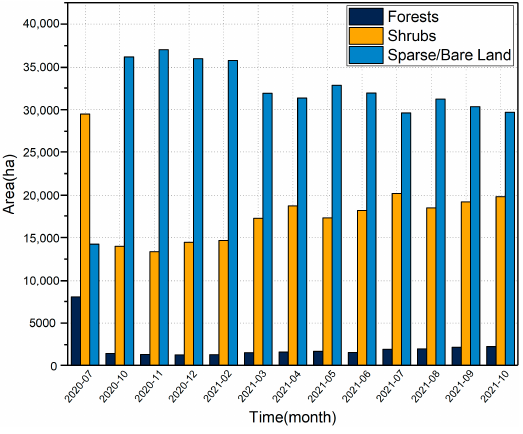
Figure 7. Vegetation community area change map.